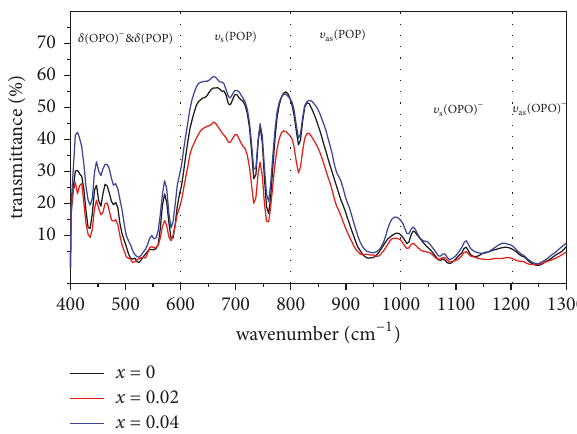
Figure 4: IR spectra of LiGd (1